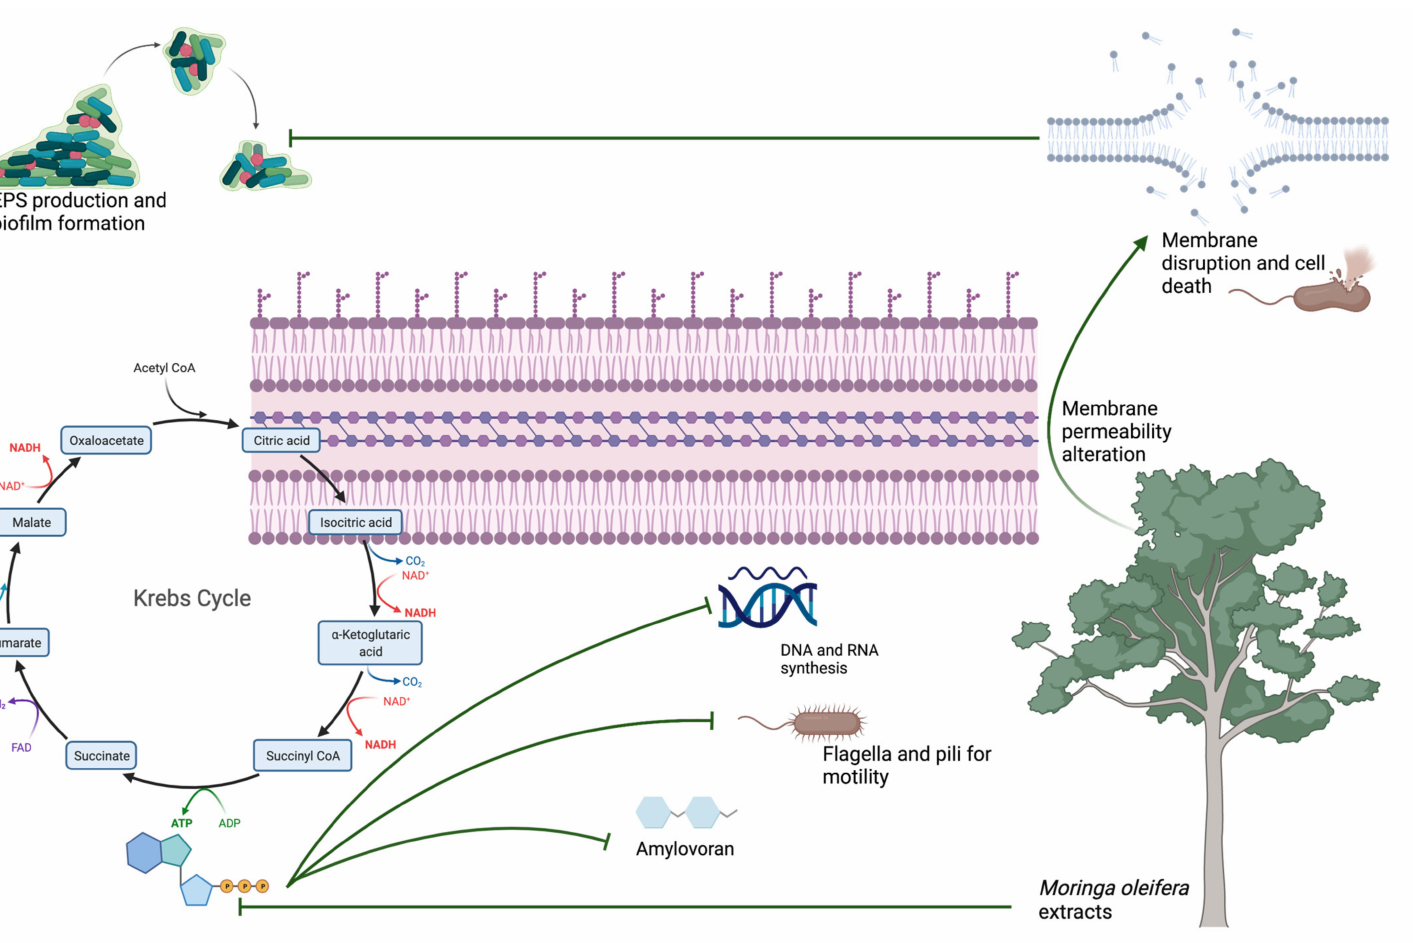
Figure 9. MOEs effects on EA virulence factors: as previously described, ATP shortening results in a halt in DNA and RNA synthesis, an inhibition of amylovoran production and a stop in motility. As the amylovoran is no longer produced, biofilm formation and consequent bacterial dissemination are impaired. Phenol’s effect of augmenting membrane permeability finally results in membrane disruption. All the summarized effects finally result in an inhibition of EA